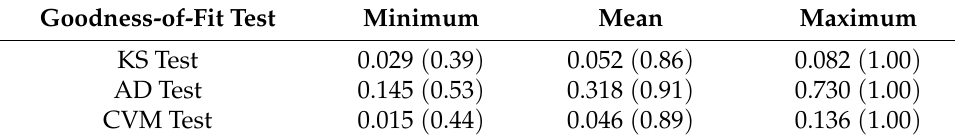
Table 4. Summary of goodness-of-fit test statistics with p -values (in parenthesis).